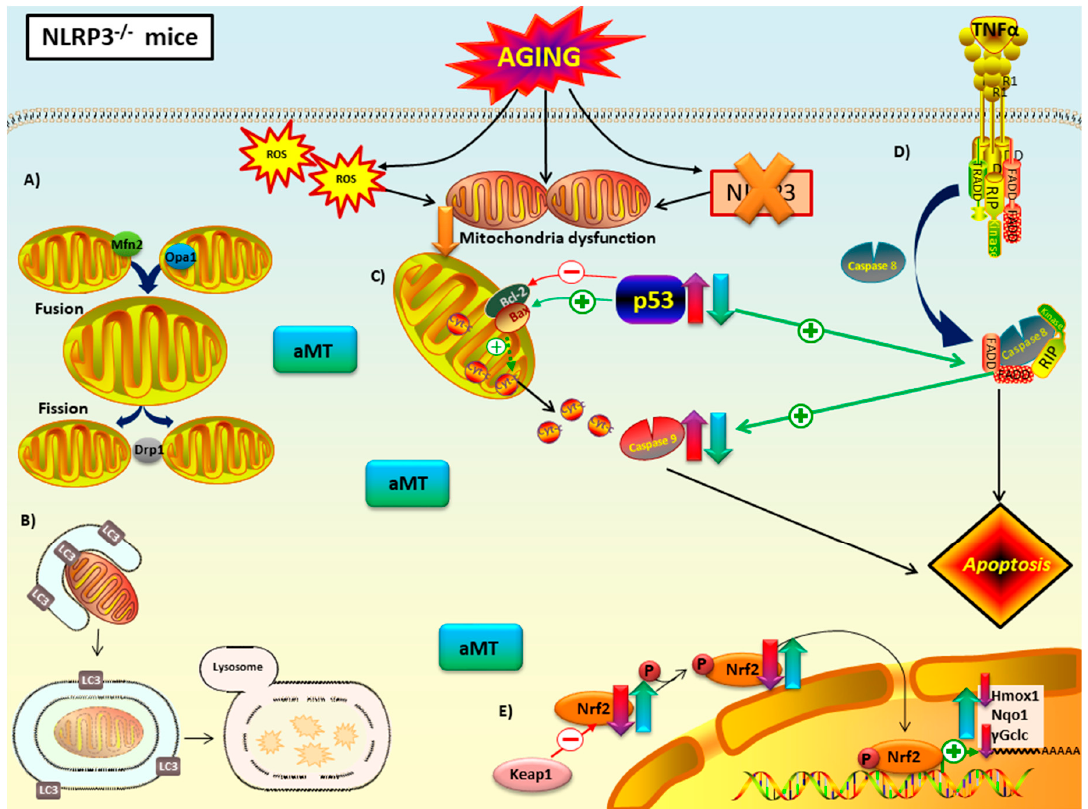
Figure 10. Proposed mechanism of melatonin in mitochondria of NLRP3 − / − mice during cardiac aging. Lack of NLRP3 inflammasome reduced mitochondria dysfunction. ( A ) Mitochondrial dynamics: the absence of NLRP3 prevented the decline in fusion (Mfn2 and Opa1) and fission proteins (Opa1) with aging. Melatonin treatment had no effect on these mice. ( B ) Autophagy (mitophagy): autophagic capacity was restored by NLRP3 deficiency. Melatonin therapy had minimal impact on autophagic capacity. ( C ) Intrinsic and ( D ) extrinsic apoptosis: loss of NLRP3 had an anti-apoptotic effect in Bax/Blc2 ratio, but not in p53 or caspase 9. The ablation of this inflammasome could trigger extrinsic apoptosis mediated by TNF α binding to death receptor. Melatonin supplementation had an anti-apoptotic effect in p53 and caspase 9. ( E ) Nrf2-dependent antioxidant response: lack of NLRP3 did not recover the decrease of this antioxidant pathway with aging. Only Nqo1 were not diminished in mutant mice. Melatonin improved this antioxidant pathway. No changes in Keap1 were reported. Red-purple arrow: impact of aging. Green-blue arrow: effect of melatonin treatment.